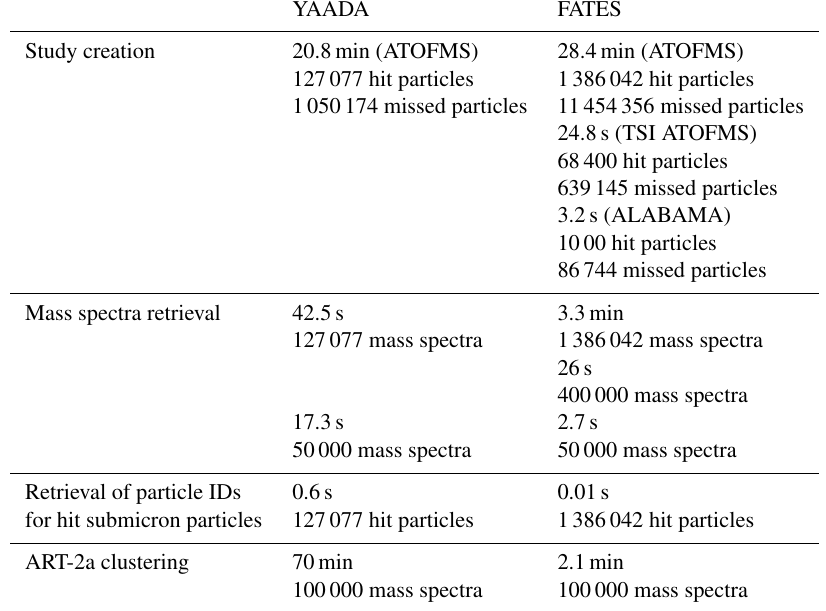
Table 2. Comparison of run times for various operations in YAADA and